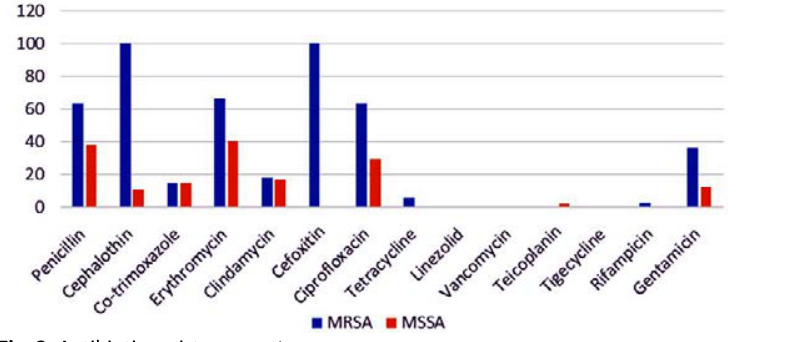
Fig. 2. Antibiotic resistance